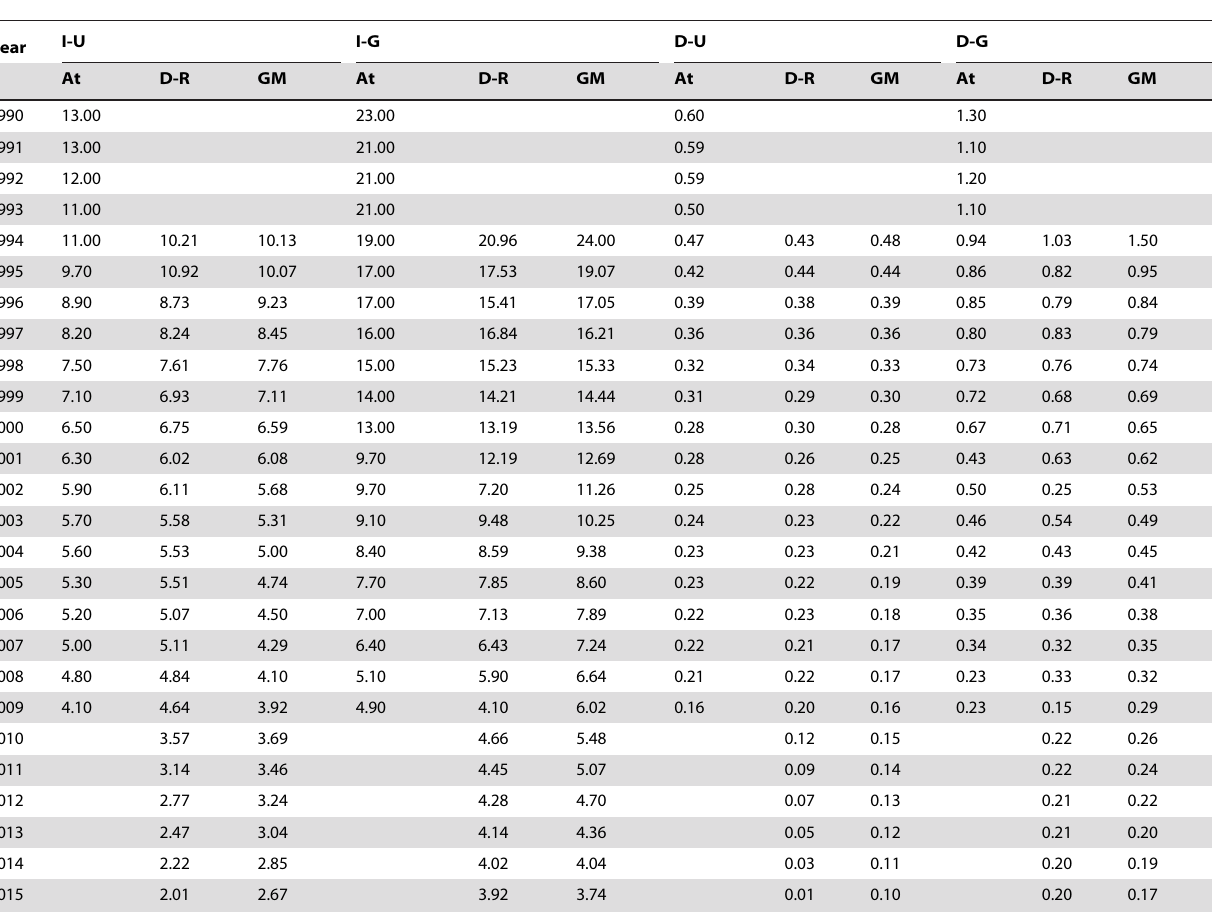
Table 1. Actual (At) and simulated (D-R & GM(1,1)) values for the incidence (I) and death (D) caused by tuberculosis in the US (U) and Germany